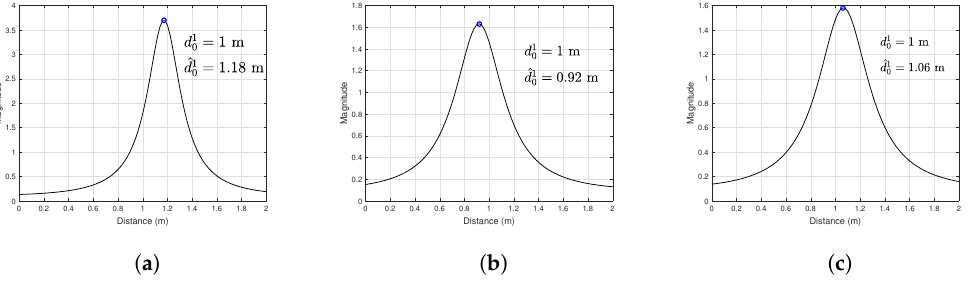
= − 45. ( b ) For θ 1 = 0. ( c ) For θ 1 = 45. 0 0 0